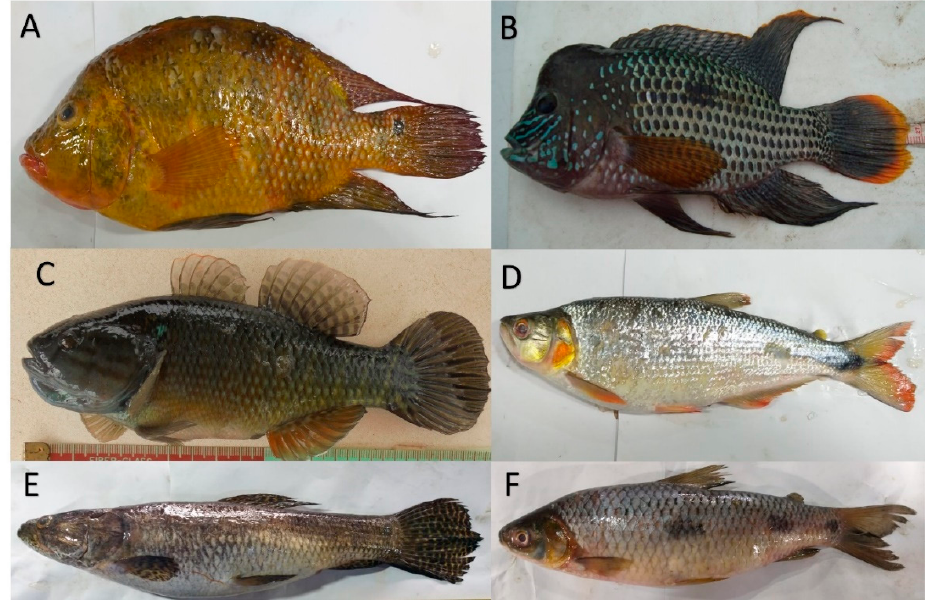
Figure 1. Six native freshwater species used in this study. ( A ) Cichlasoma festae; ( B ) Andinoacara rivulatus; ( C ) Dormitator latifrons; ( D ) Brycon dentex; ( E ) Hoplias microlepis; ( F ) Leporinus ecuadorensis.